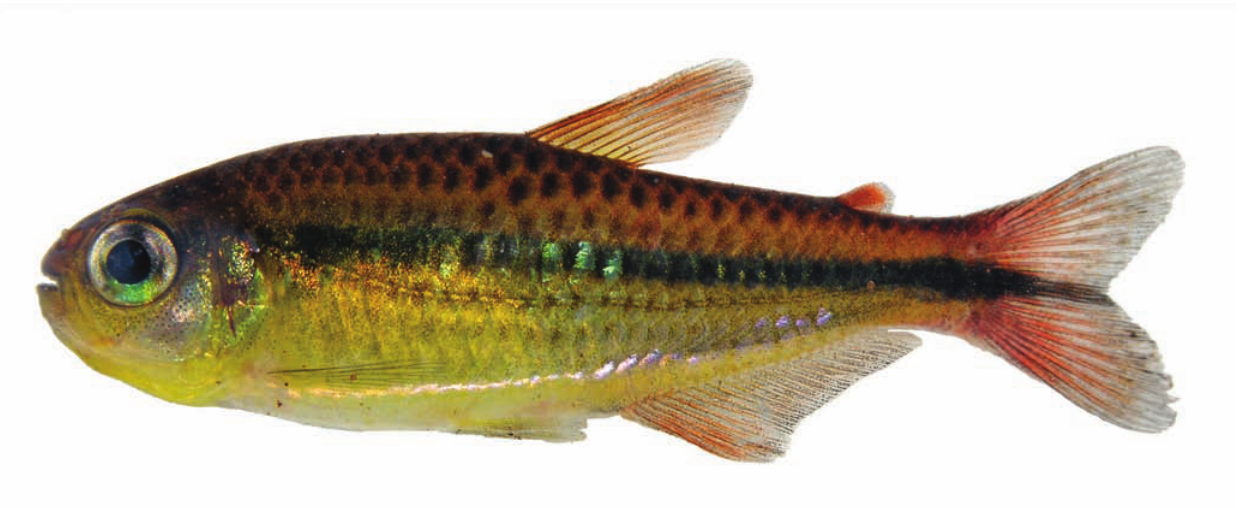
Fig. 9. Moenkhausia petymbuaba , photographed alive, MZUSP 97530, Brazil, Pará, Altamira, tributary to rio Curuá, rio Xingu basin. Photo by M. Sabaj